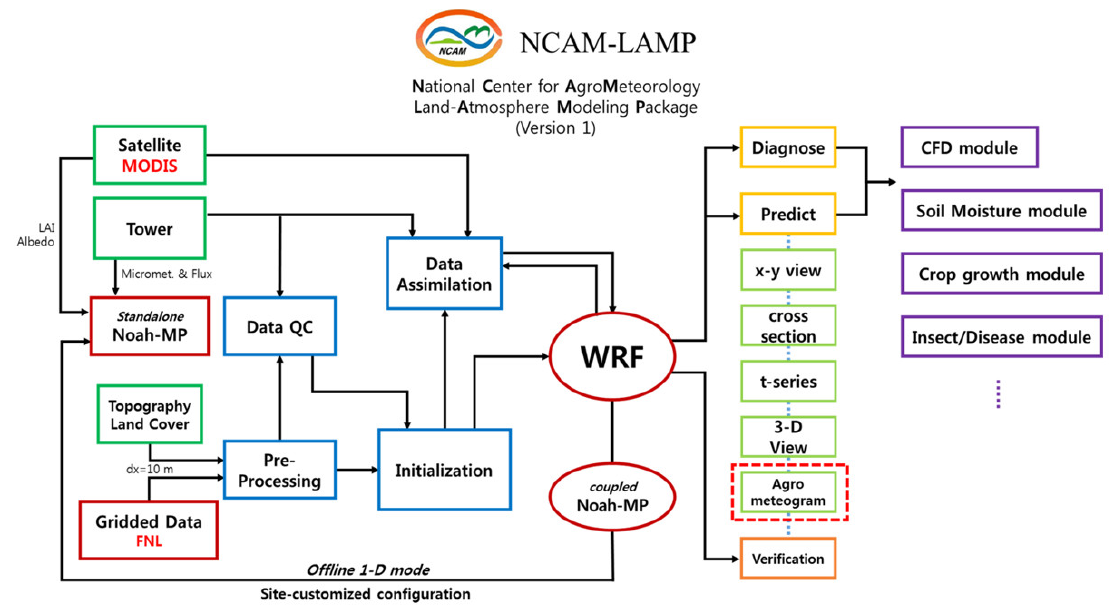
Figure 4. Framework of the medium-range weather prediction model implemented in the National Center for AgroMeteorology-Land-Atmosphere Modeling Package (NCAM-LAMP). The LAMP diagnosis and prediction data are used as high-resolution meteorological input data for poultry heat stress model in this study.